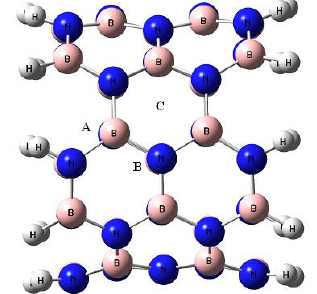
Figure 1. Atomistic configurations of physisorption with the axis of an O molecule 2 perpendicular above a boron atom on the (5, 5) BNNT (A), above a nitrogen atom (B) and exterior / interior a hexagon with a molecular axis perpendicular (C) The physisorption energy (E ) of one O molecule on the BNNT wall can be physisorption 2 calculated as